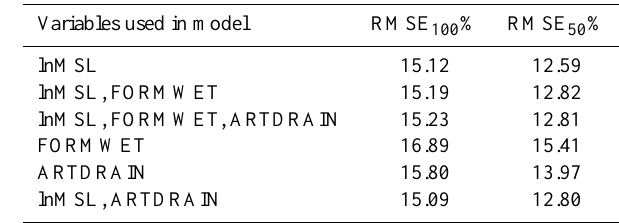
Table 3. Variation in the mean RMSE corresponding to T =100 and 50 for different sets of pooling variables: variables that predict L-CV